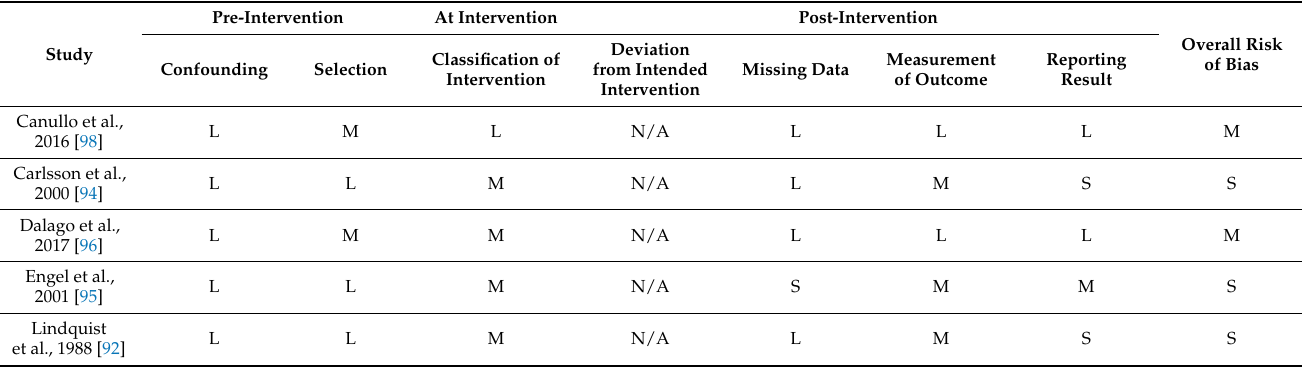
Table 2. Risk of bias assessment (ROBINS-I) L = “low risk of bias”; M = “moderate risk of bias”; S = “serious risk of bias”; C = “critical risk of